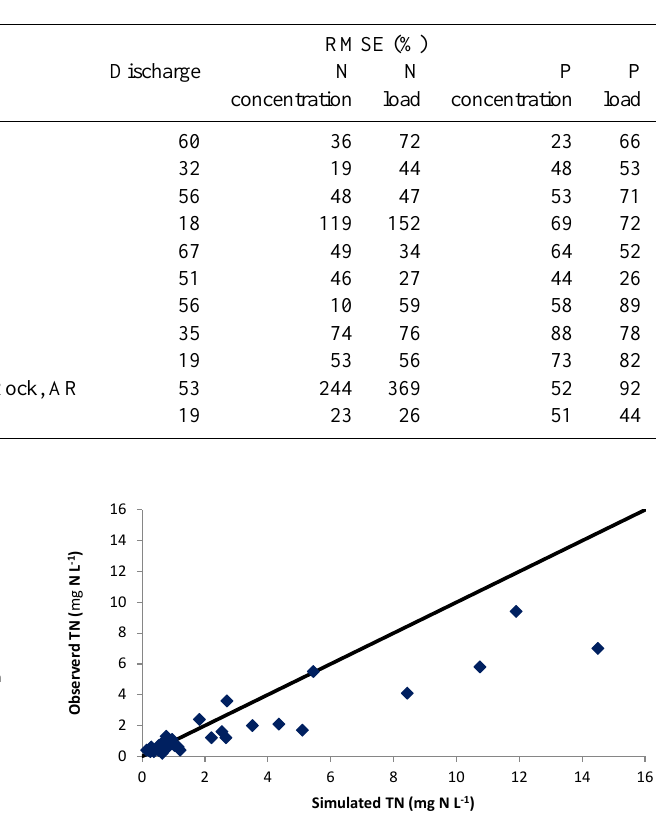
Table 4. RMSE for simulated vs. measured N concentrations, N load, discharge, P concentration and P load for 11 stations in the Mississippi River, Ohio River, Red River, Missouri River and Arkansas River. Measurement frequency ranges from 28 per year to 3. Years with less than 6 observations were excluded.